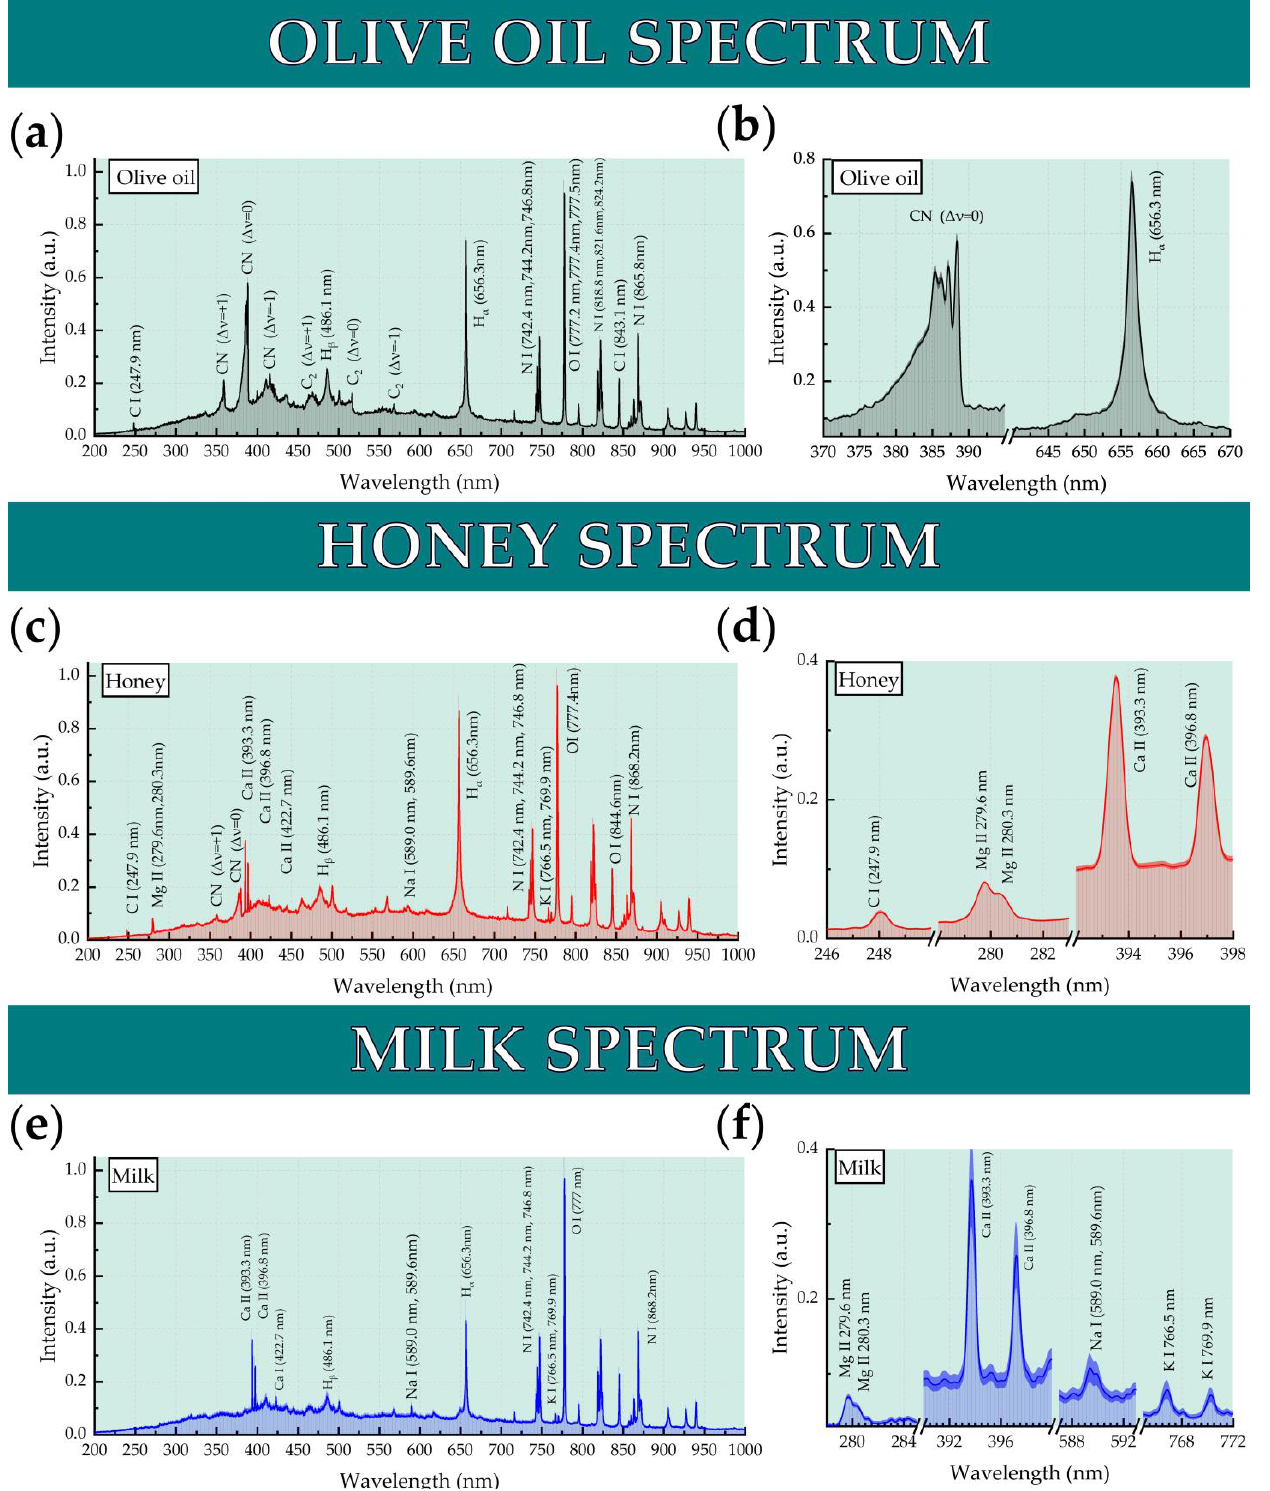
Figure 4. ( a )Typical LIBS spectrum of olive oil. ( b ) Enlarged view of the olive oil spectrum indicating the CN band and the H α line. ( c ) Typical LIBS spectrum of honey. ( d ) Enlarged view of the honey LIBS spectrum indicating the atomic line of C and the ionic lines of Mg and Ca. ( e ) Typical LIBS spectrum of milk. ( f ) Enlarged view of the milk LIBS spectrum indicating the ionic lines of Mg and Ca and the atomic lines of Na and K.